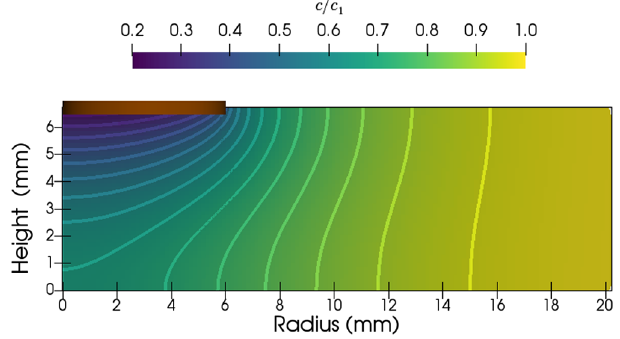
FIG. 16. Radially symmetric simulation of the concentration field c=c 1 below a yeast colony (the thick brown bar) on the surface of our viscous liquid after 48 h and at η ¼ 400 (cid:2) 50 Pa s. Equally spaced contours of constant concentration are